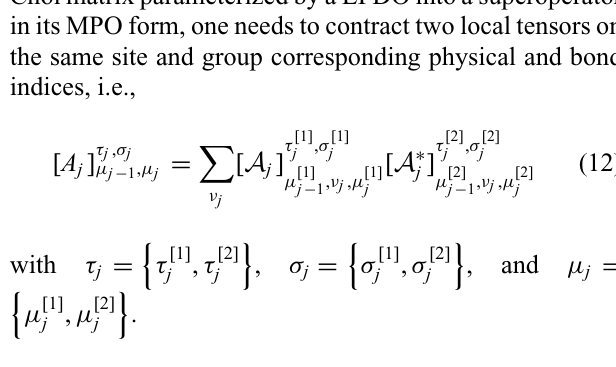
(cid:7) and for each site takes O ( N N j j